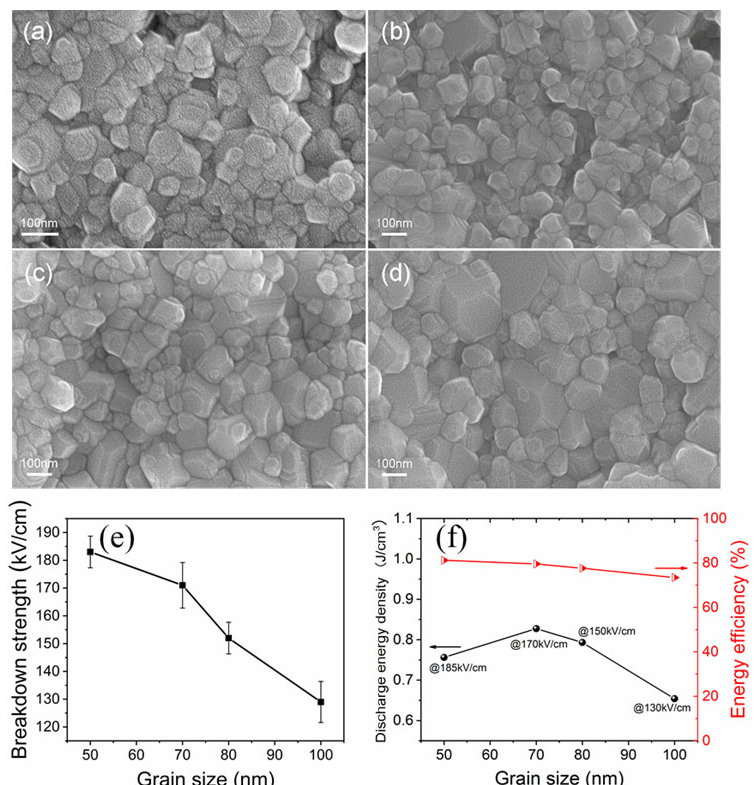
Fig. 16 Microstructure of BaTiO 3 -based ceramics with various grain sizes: (a) 49±17 nm, (b) 67±28 nm, (c) 77±34 nm, and (d) 105±44 nm. (e) Dielectric breakdown strength as a function of the grain size with the standard deviations. (f) Maximum recoverable energy density and the corresponding efficiency of the BaTiO 3 -based ceramics as a function of grain size. Reproduced with permission from Ref. [105], © The American Ceramic Society 2020.